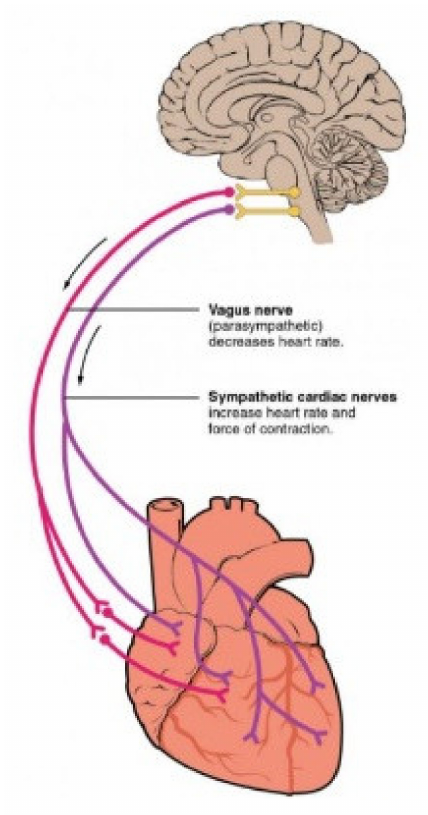
Figure 2. The ANS connection between the brain and heart